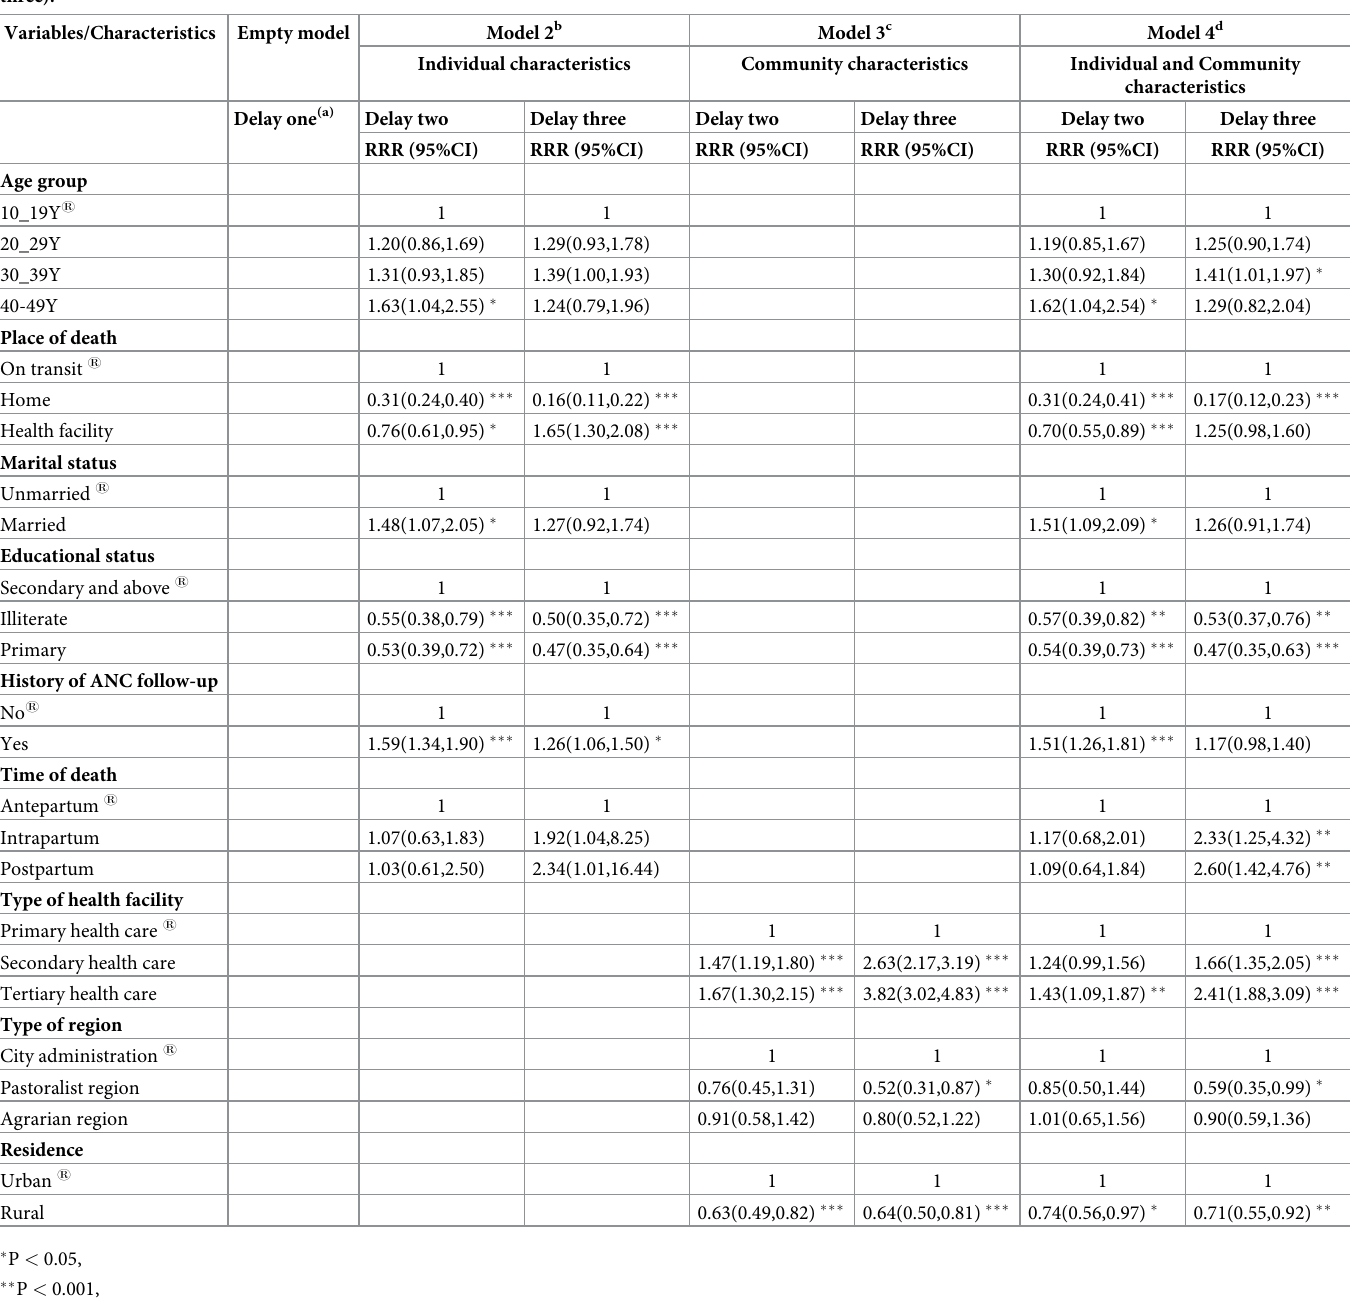
Table 4. Multilevel multinomial logistic regression analysis in assessing the factors associated with delay factor related to maternal death (both delay two and